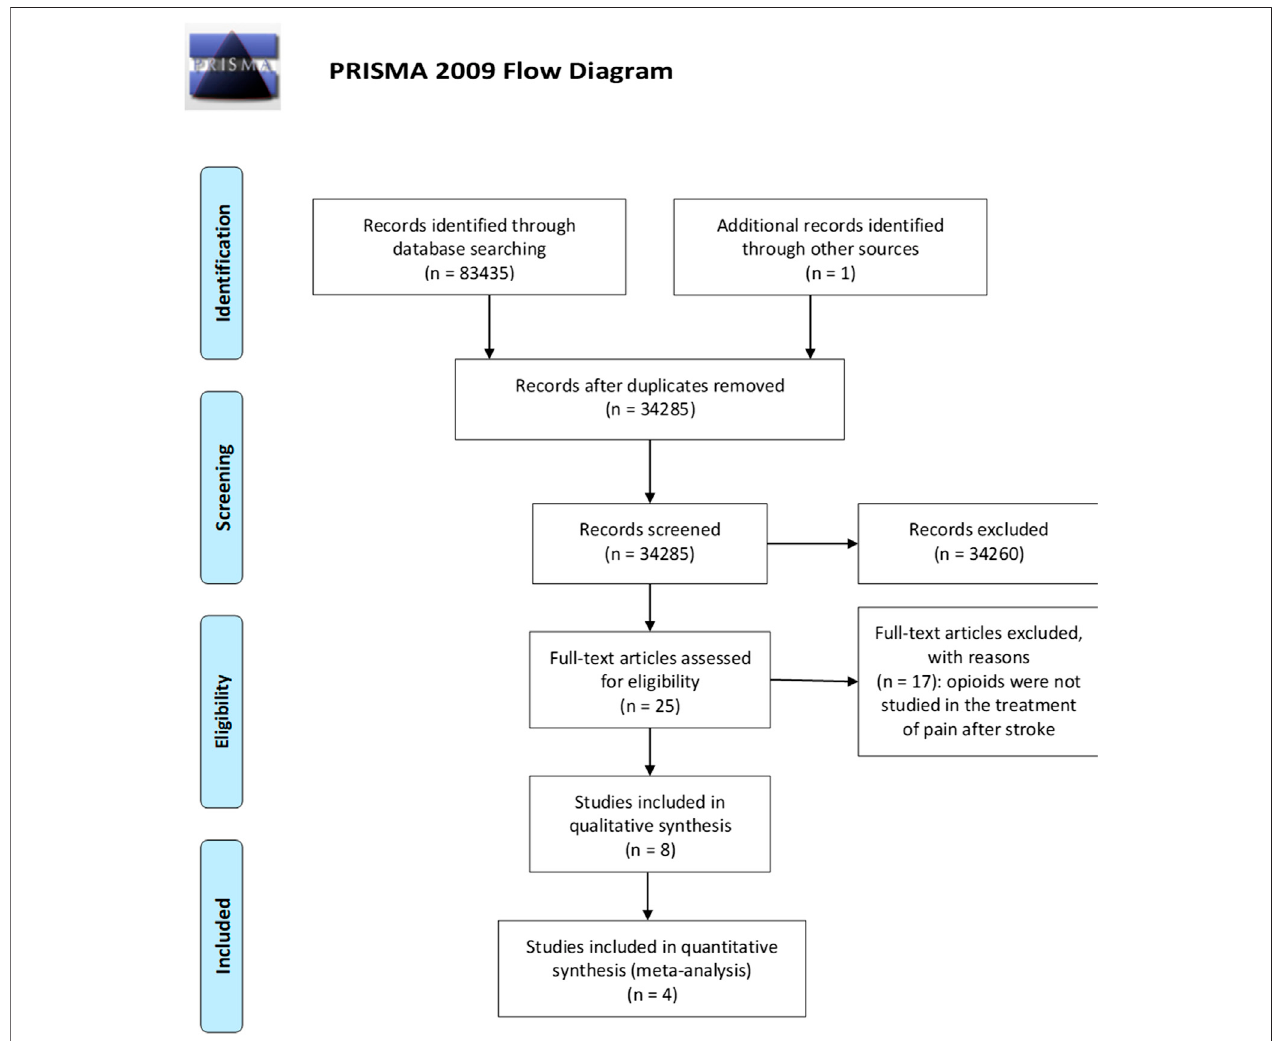
FIGURE 1 | Process of selection of the studies eligible for the qualitative analysis according to the PRISMA guidelines (Moher et al., 2009).